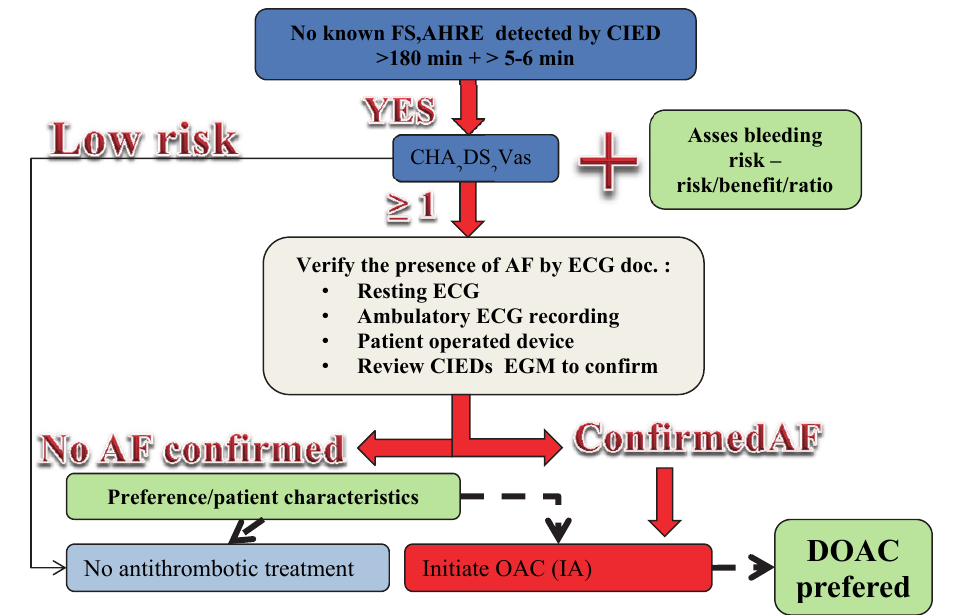
Fig. 3. Algorithm for anticoagulation initiation in patients with AHRE as a surrogate for AF detec- tion. Modified from Kirchhof P. et al. Eur J Cardiothorac Surg 2016;50(5):e1-e88.